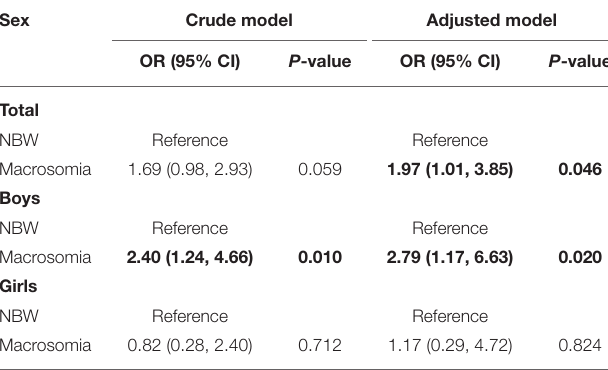
TABLE 3 | Odds ratios of LVH in the macrosomia group compared with the NBW group by